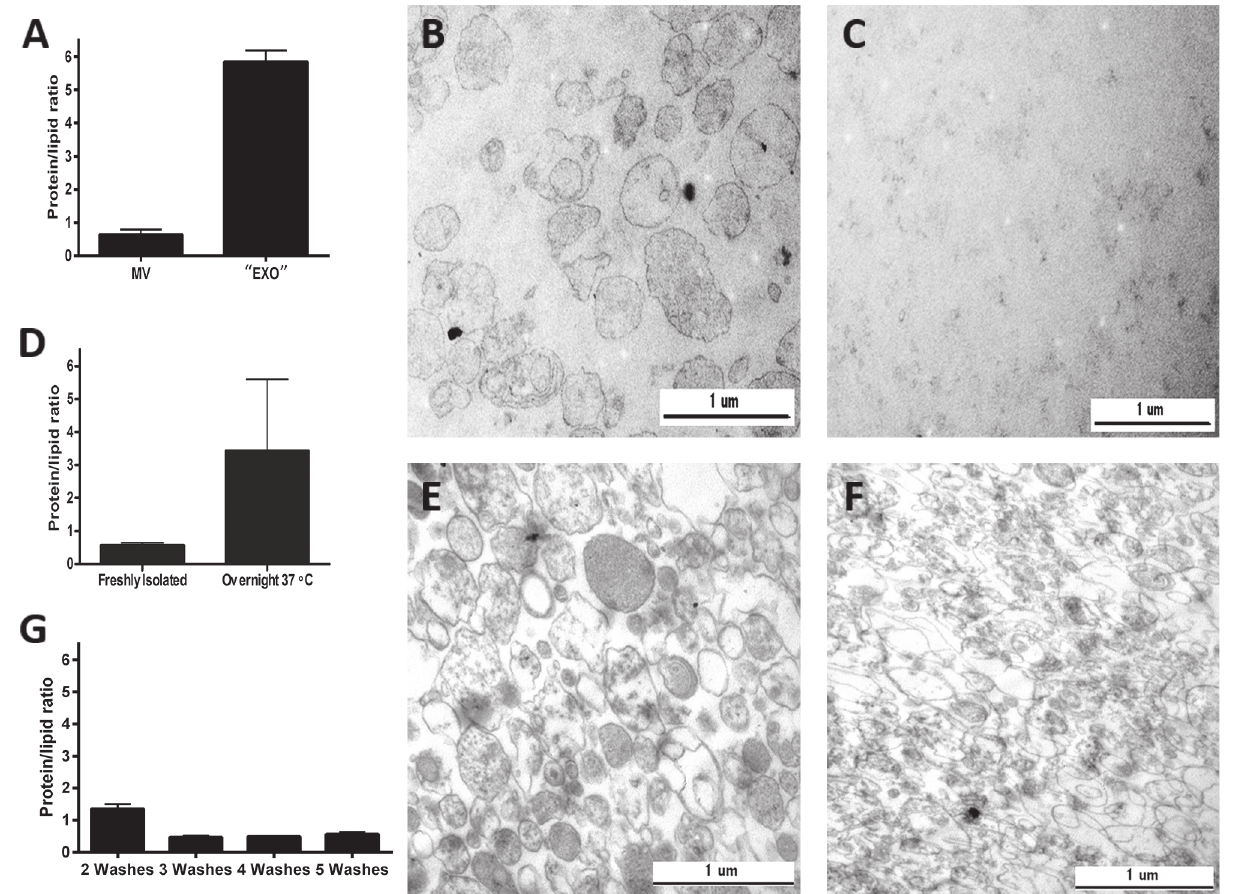
Fig 4. Protein to lipid ratio as a quality control parameter of EV preparations. A-C show results of 4 independent experiments where there were visible pellets for both the 20000g (MV) and 100,000g ( “ EXO ” ) preparations. While the normal protein to lipid ratio of MVs reflected a true vesicular pellet as also demonstrated by electron microscopy (B), a strongly elevated protein to lipid ratio suggested the absence of EXOs as was later confirmed by electron microscopy